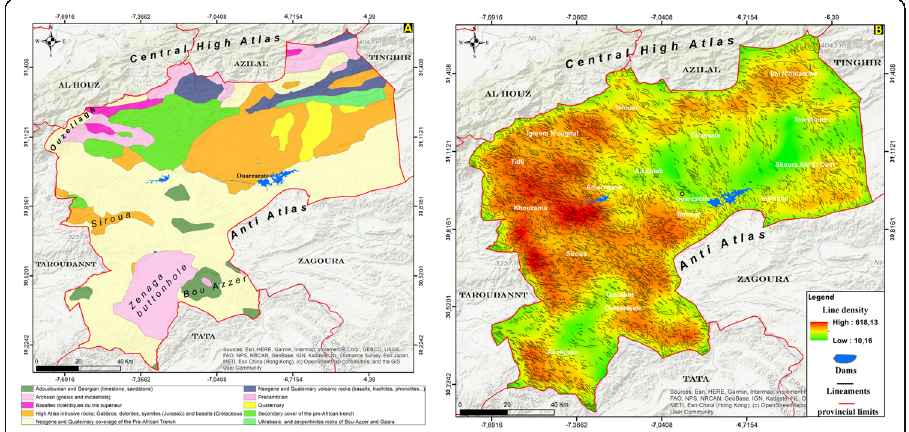
Fig. 4 Large-scale geology of the study area ( A ). Line density of the study area ( B